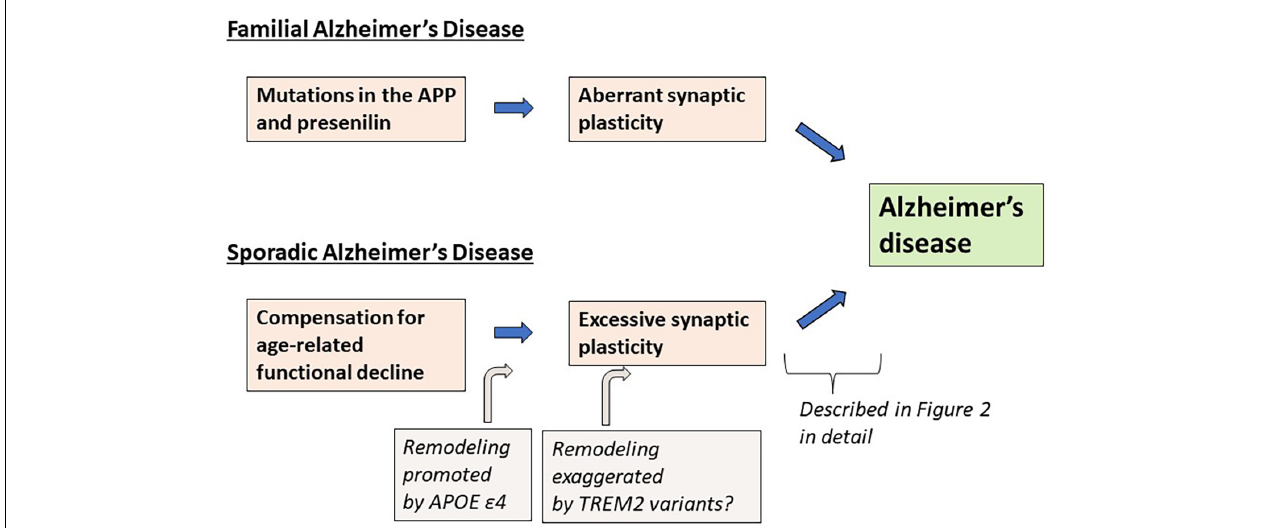
FIGURE 1 | Summary of the synaptic plasticity hypothesis of Alzheimer’s disease.